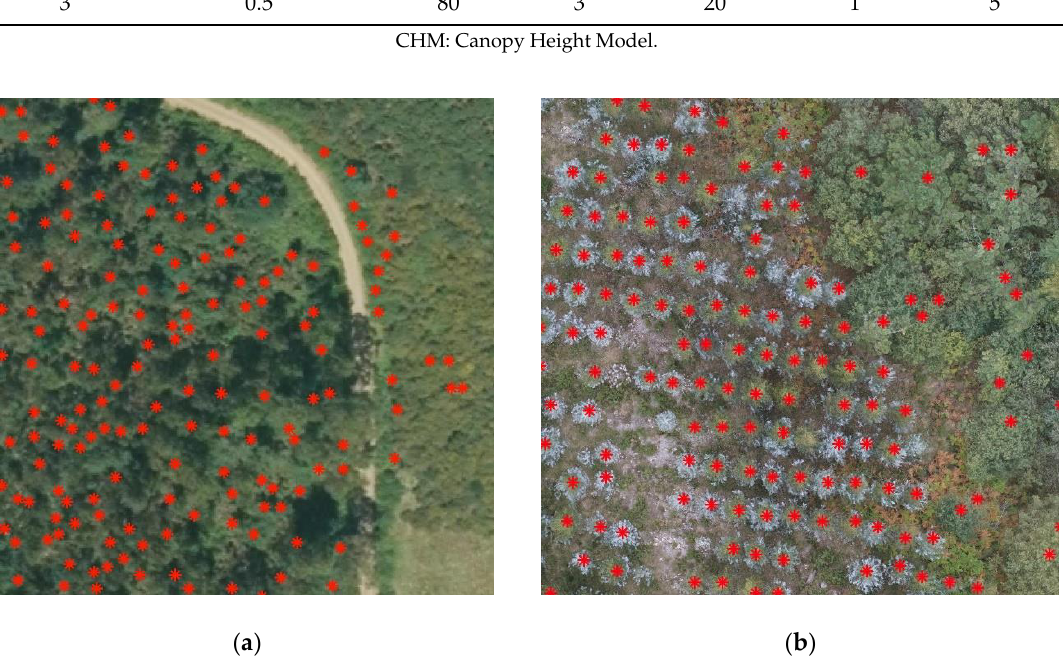
Figure 9. Results of the Watershed Delineation (WD) process for Dataset 2 ( a ) and Dataset 3 ( b ). Trees are represented by red dots.